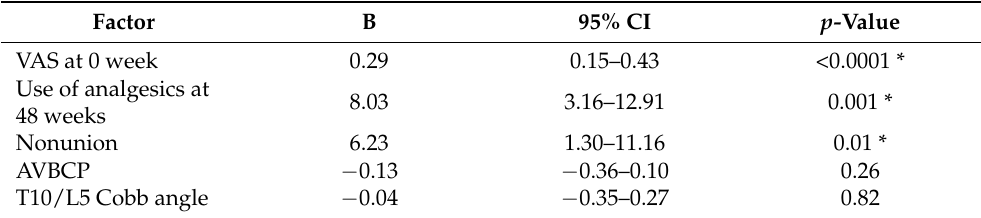
Table 4. Forced-entry multiple regression analysis: independent factors contributing to low back pain at 48 weeks after OVF.